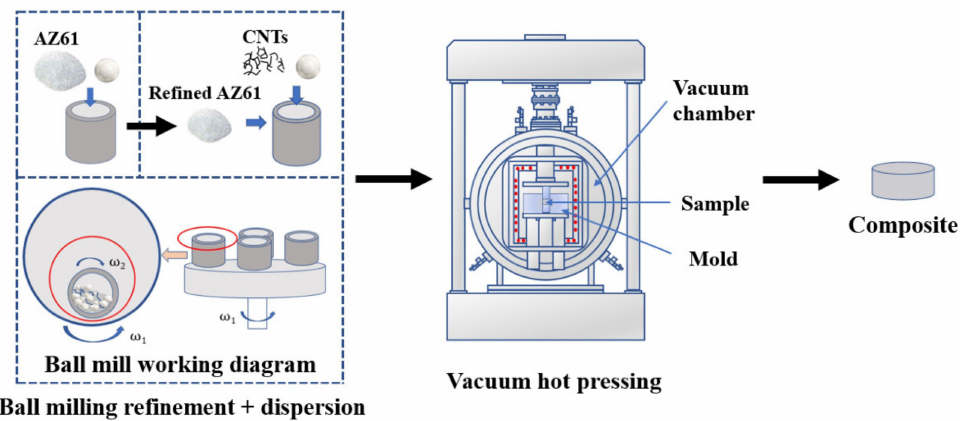
Figure 1. Preparation flow chart of